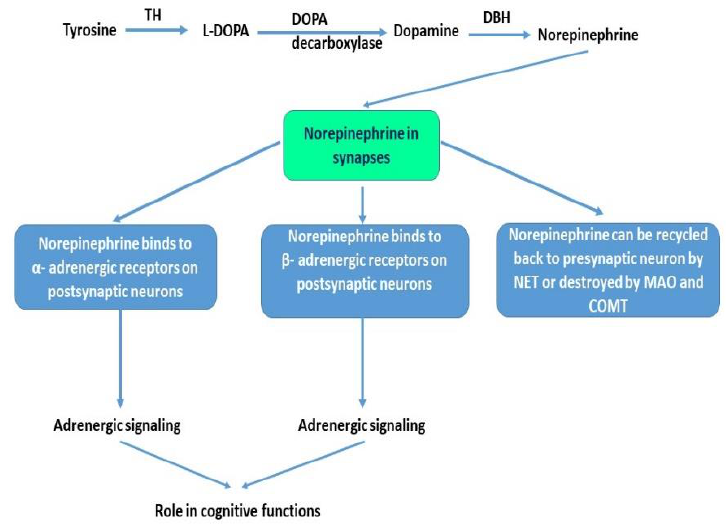
Figure 2. The role of norepinephrine at synapses. Norepinephrine is synthesized in a multistep process. Tyrosine is converted to L-DOPA via the activity of tyrosine hydroxylase (TH). L-DOPA is then decarboxylated via DOPA decarboxylase into dopamine. Dopamine via dopamine beta-hydroxylase (DBH) is then converted to norepinephrine (NE). NE is released at synapses where it can bind to α - adrenergic receptors or β - adrenergic receptors on postsynaptic neurons to modulate neuronal firing or modulate adrenergic neurons signaling. NE excess can be eliminated via the activity of monoamine oxidase (MAO) or catechol-O-methyltransferase (COMT). NE can also be recycled back to presynaptic neurons via the NE transporters (NET).